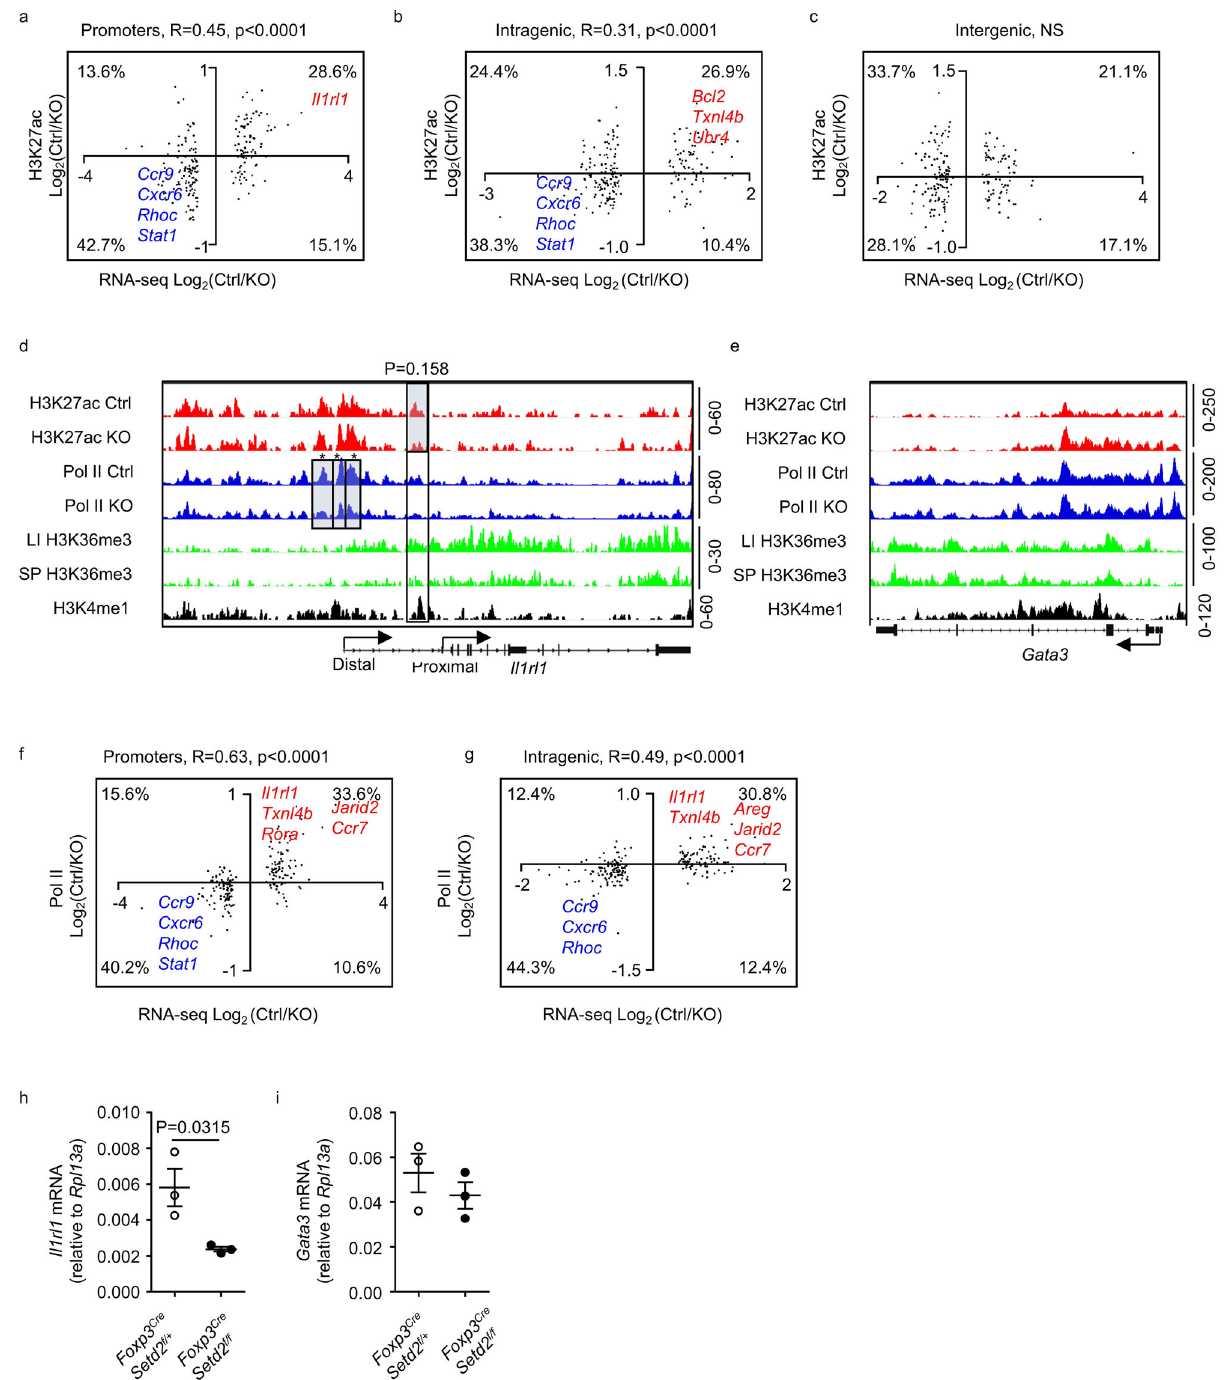
Fig. 7 | Setd2 regulates gene transcription by modulating the activity of pro- moters and intragenic enhancers in tTreg cells. a – c H3K27ac CUT&Tag analysis was performed with Treg cells puri fi ed from 2-week-old large intestinal LPLs of Foxp3 Cre-YFP Setd2 f/+ (Ctrl)or Foxp3 Cre-YFP Setd2 f/f (KO)mice. d , e Genomebrowsertracks of H3K27ac, RNA Pol II CUT&Tag peaks, H3K36me3 peaks with published Treg H3K4me1(DRP003376) peaks at the Il1rl1 and Gata3 locus. Boxes highlight differ- entially expressed peaks with or close to reach statistically signi fi cant differences analyzed by DEseq2. f , g RNA Pol II CUT&Tag analysis was performed with splenic Treg cells nuclei of IL-2c-treated Foxp3 Cre-YFP Setd2 f/+ (Ctrl) or Foxp3 Cre-YFP Setd2 f/f (KO) mice. a – c , f , g Correlation analysis was performed on top signi fi cantly changed genes identi fi ed by intestinal Treg RNA-seq using Log 2 (fold change) (Fc) of gene